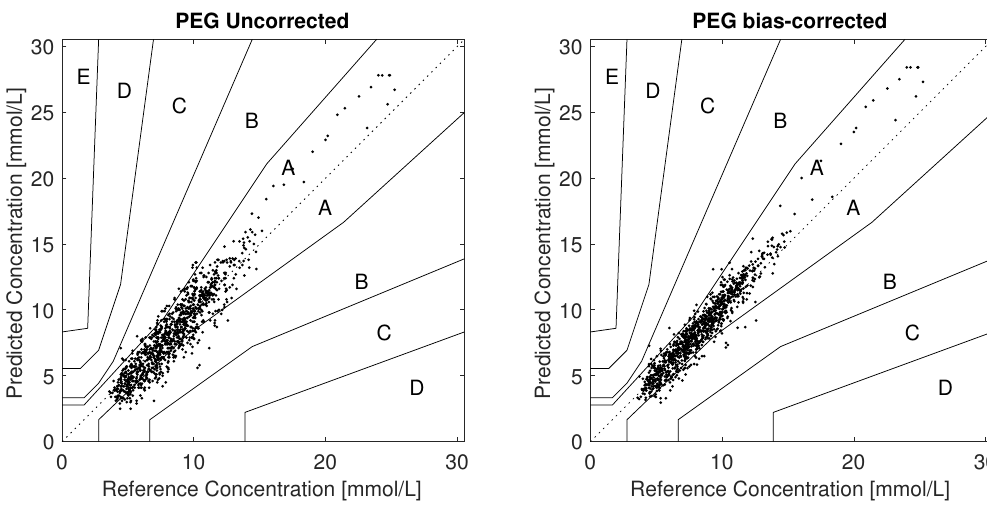
Figure 3. Parkes/Consensus Error Grid plots. Left: Uncorrected Right: Bias corrected Bias correction per individual makes 91.2% of the paired points lie in zone